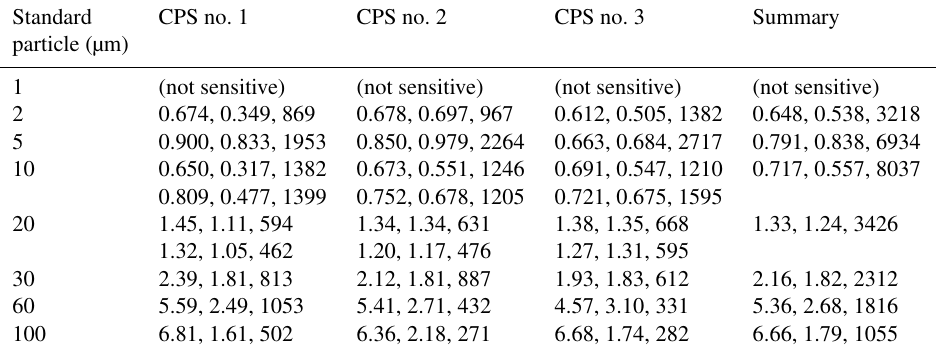
Table A3. Results from the laboratory experiments on the I 55 values for three CPS instruments (nos. 1, 2, and 3) for various standard spherical particles. In each table element for individual CPS instruments and for the summary column, the average I 55 (V), its standard deviation, and the number of particles used in each experiment are shown. For the 10 and 20µm standard particles, two sets of experiments were conducted on different days. The summary results in the fifth column have been obtained by combining the results from all the three